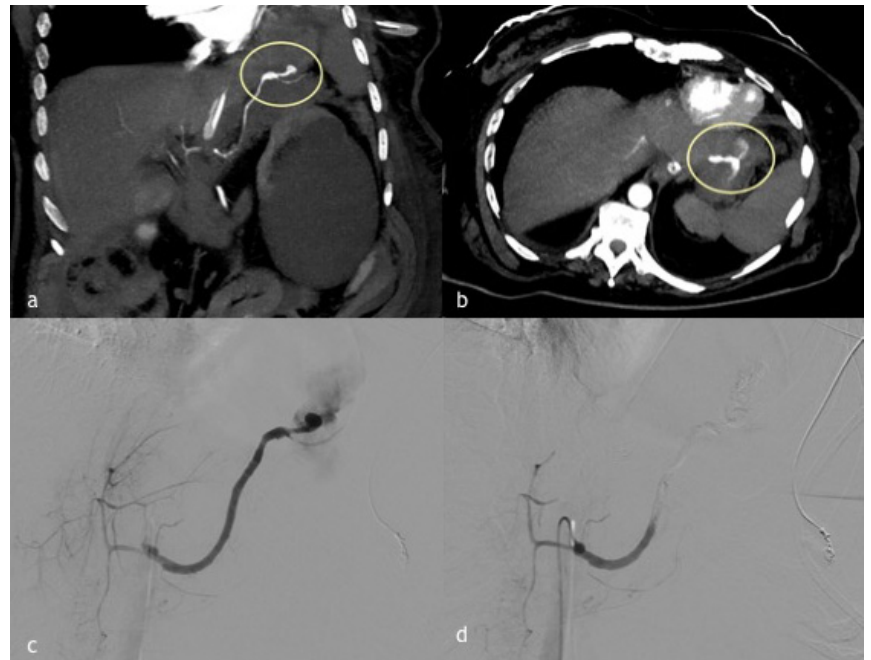
Figure 3. ( a – d ). A 45-year-old woman presented a massive hematemesis after gastroentero-anastomosis due to ingestion of caustics. ( a , b ) Coronal and axial MPR reconstruction images demonstrate a spastic splenic artery with PSA formation directly bleeding in the stomach (circle). ( c ) Digital subtraction angiographic image shows splenic artery PSA rupture with massive bleeding in the stomach. ( d ) Post- embolization angiographic control shows complete occlusion of the splenic artery obtained with 1:1 mixture Glue/Lipiodol.